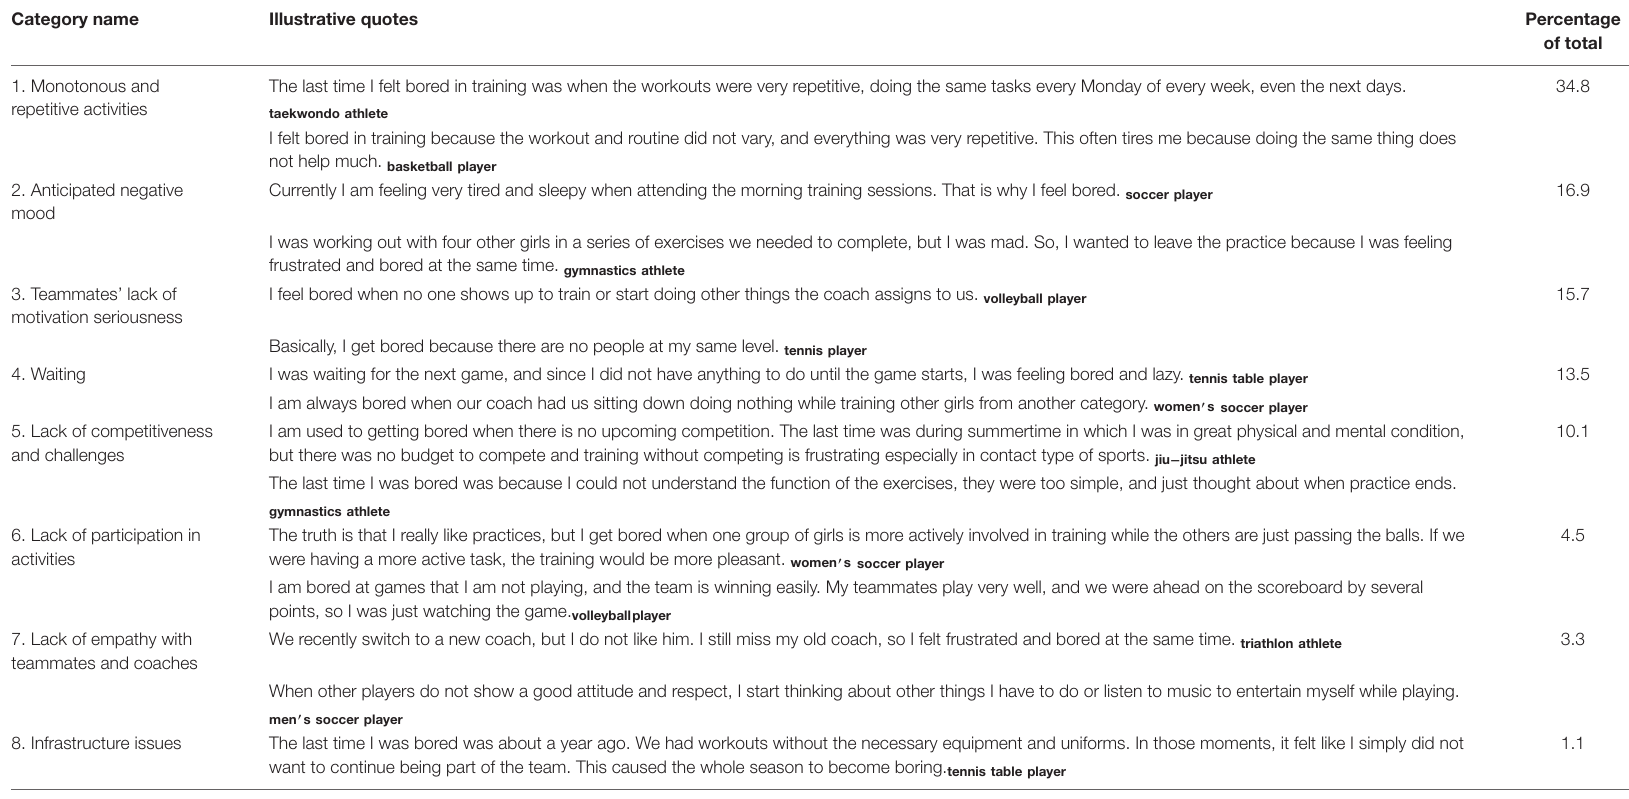
TABLE 2 | Percentage of athletes’ boredom incidents falling into each content